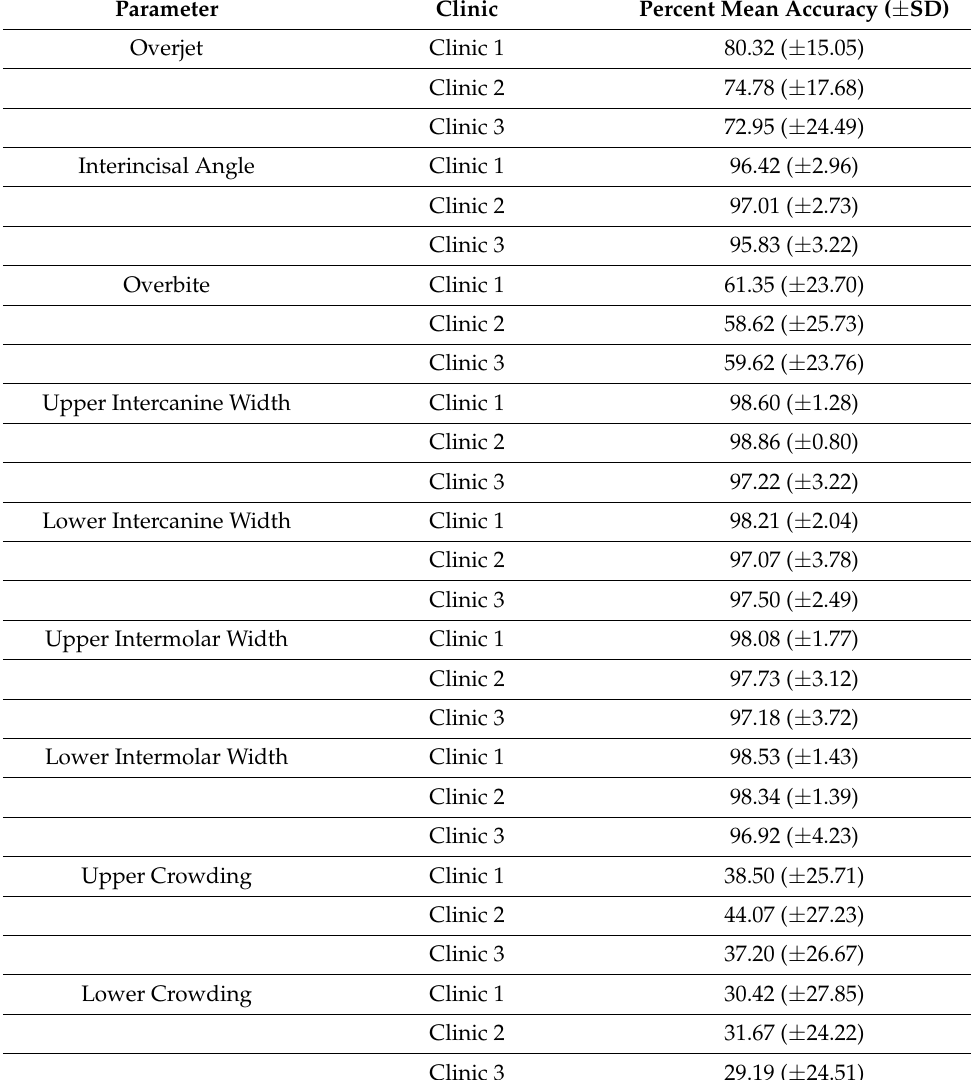
Table 2. Comparison of the accuracies between the different